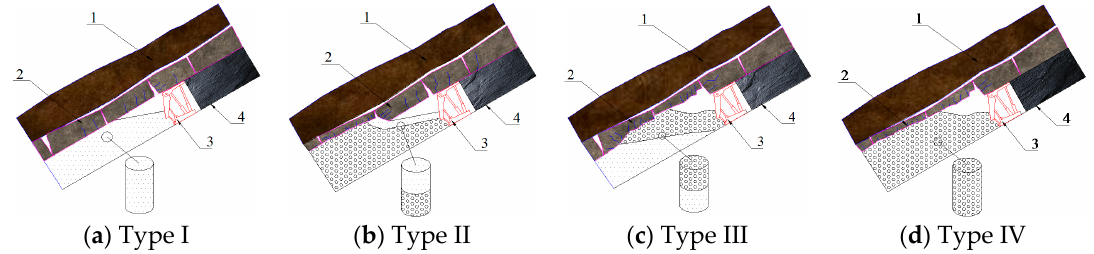
Figure 3. Classification of the backfilled SCMC. 1-main roof; 2-immediate roof; 3-hydraulic support; 4-coal body.